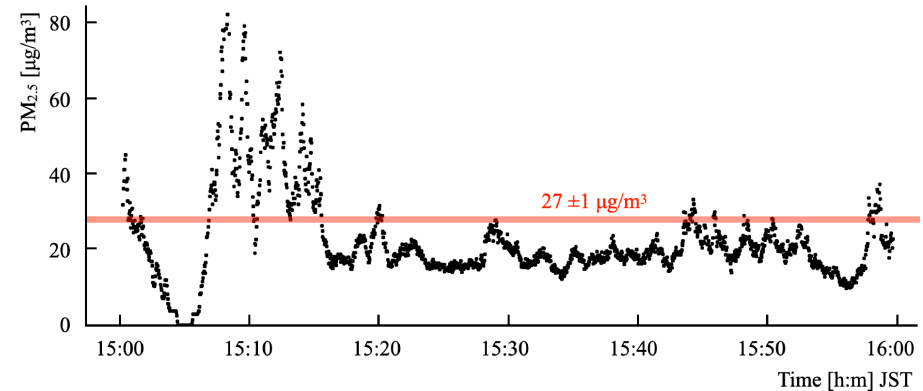
Figure 13. Time-series output values from